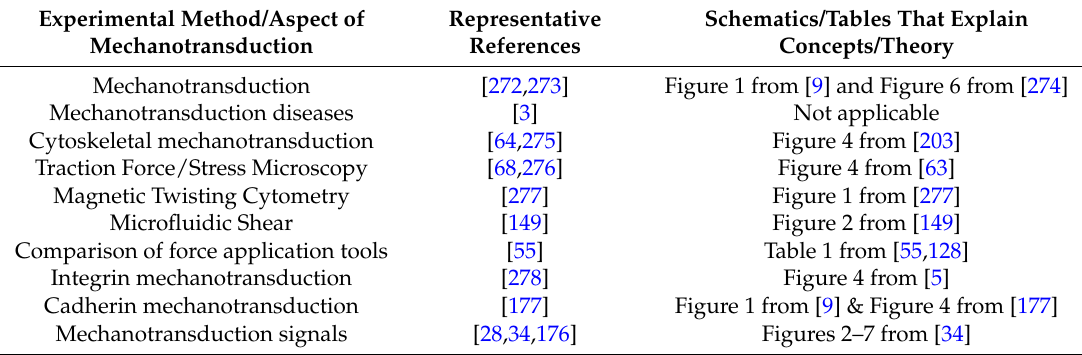
Table 1. Summary of